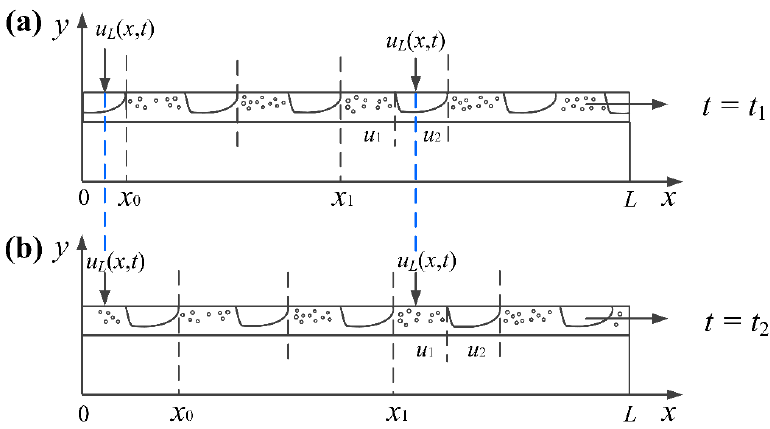
Figure 3. The transient pattern of slug flow in two typical moments (( a ): at t = t 1 ; ( b ): at t = t 2